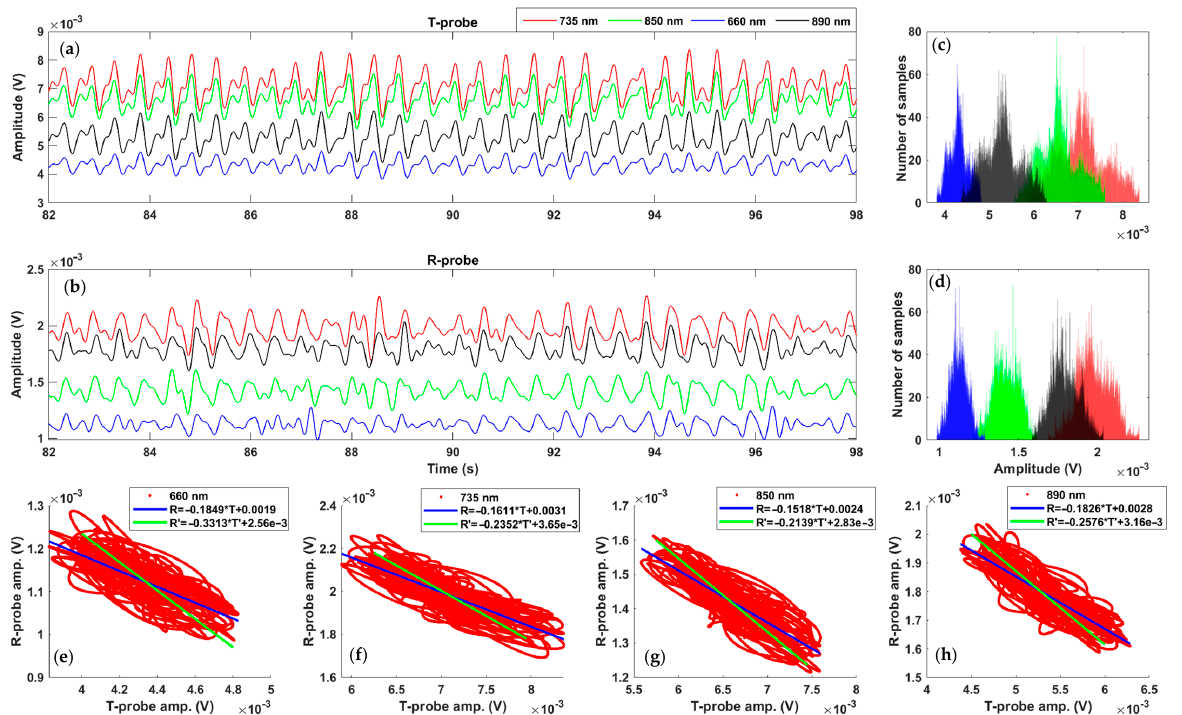
Figure 10. PPG results in baseline for the four wavelengths in both modes (( a ): transmission, ( b ): reflection) and example of signal processing result (( c , d ): histogram of both PPG, ( e – h ): PPG clouds of dots allowing the calculation of the Bravais–Pearson correlation coefficients and regression analysis).